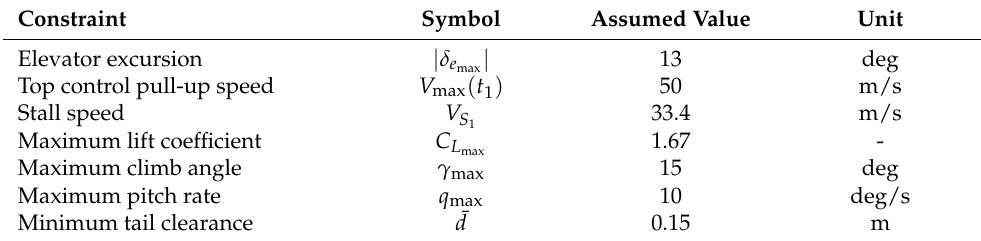
Table 2. Problem-relevant specifications, constraints, and boundaries.